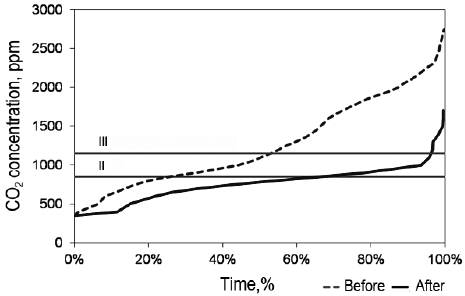
6. Measurement results of indoor CO 2 concentration before and after the renovation